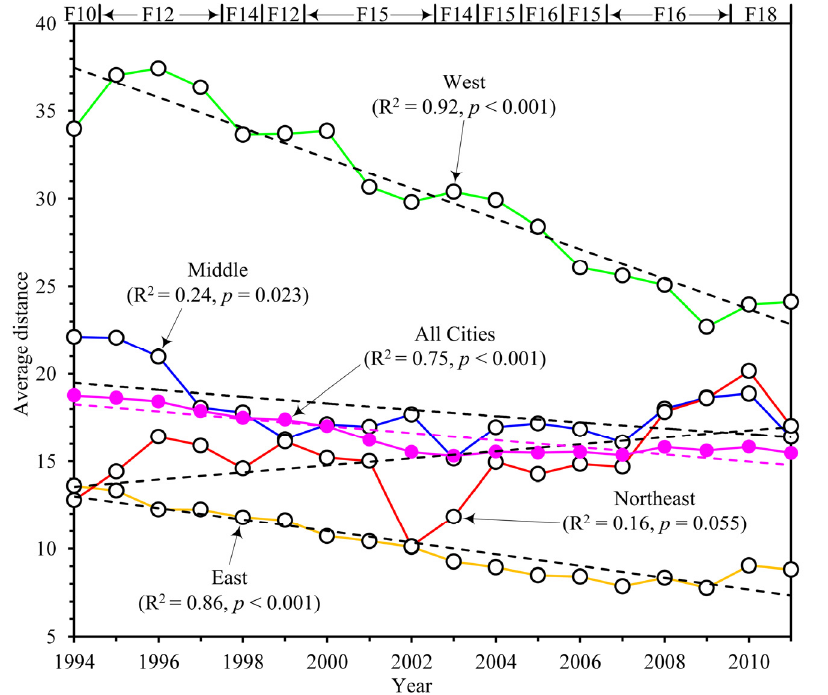
Figure 4. Annual variations of regional average ternary distance changes of China’s cities from 1994 to